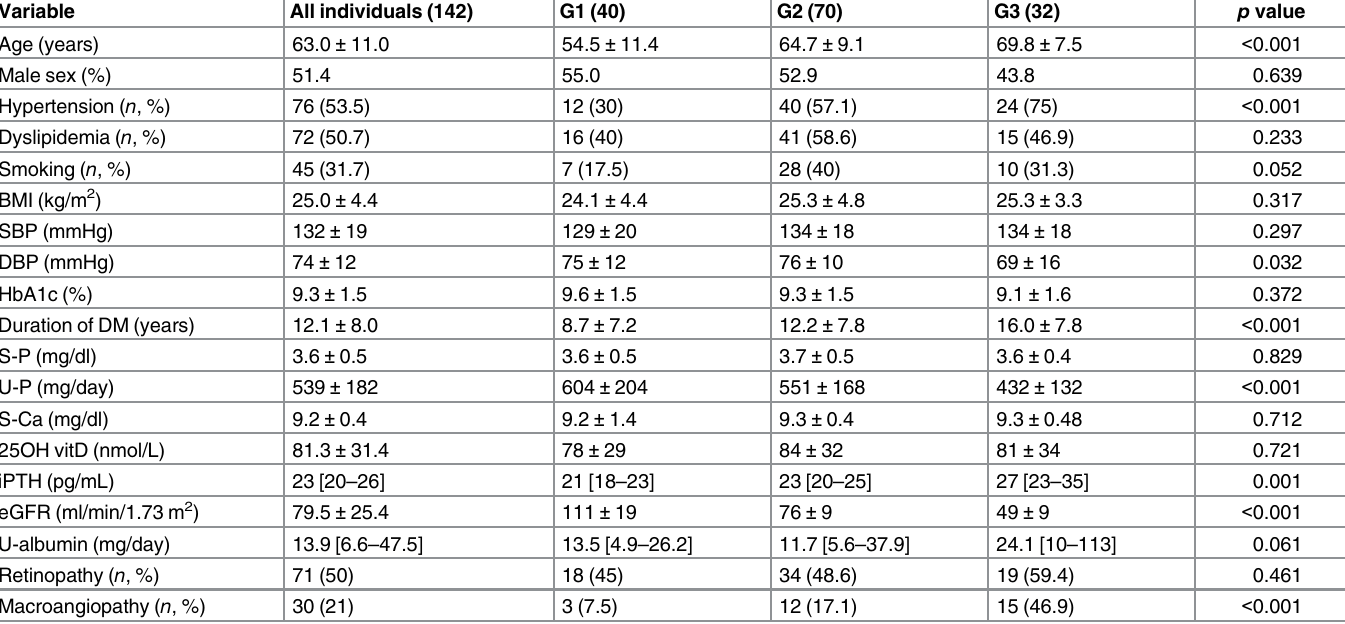
Table 1. Clinical characteristics of the participants with CKD stages G1 – G3. BMI, body mass index; DM, diabetes mellitus; SBP, systolic blood pres- sure; DBP, diastolic blood pressure; HbA1c, hemoglobin A1c; S-P, serum phosphate; U-P, 24-h urinary excretion of phosphate; S-Ca, serum calcium; 25OH